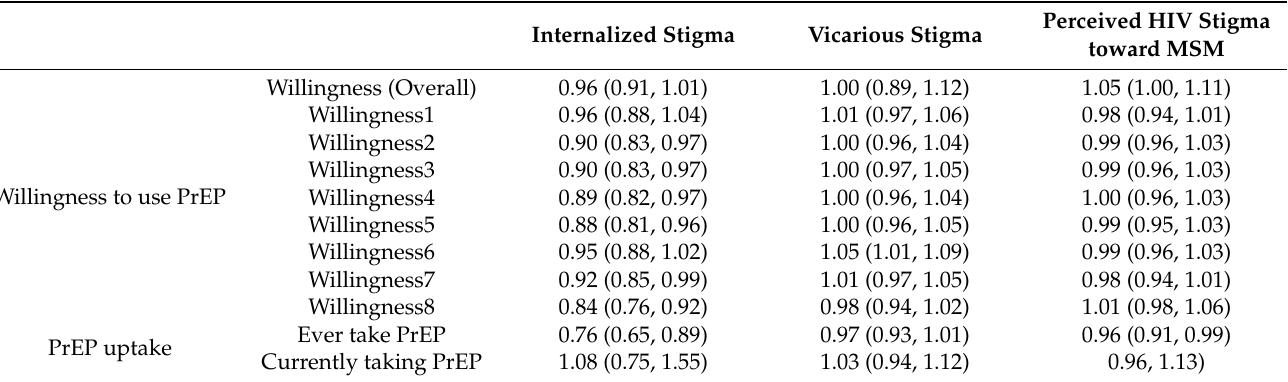
Perceived HIV Stigma toward